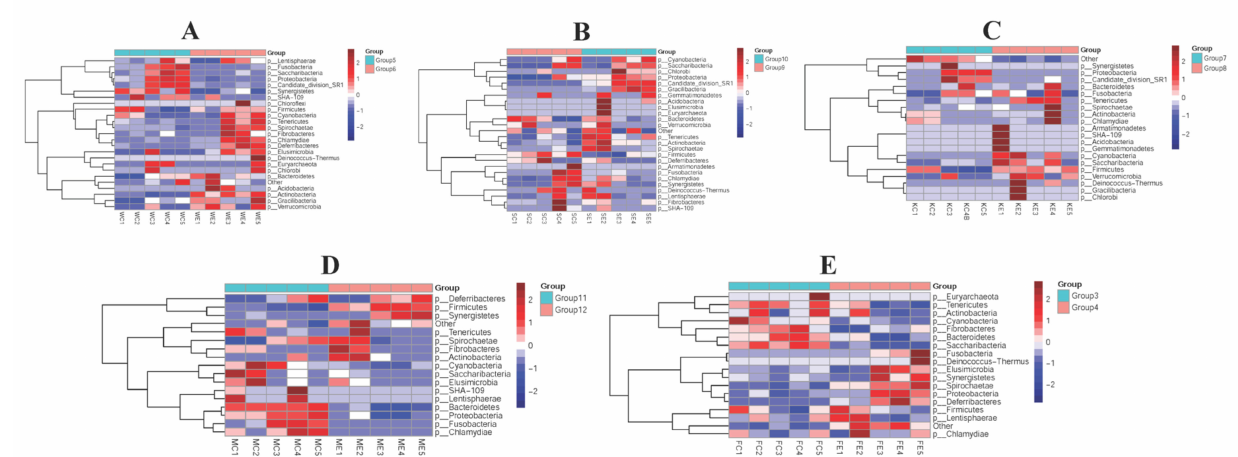
Figure 4. Heatmap showing the efficacy of colistin on piglet microbiome change at phylum levels. ( A ) Stomach (Group 6, Group 5); ( B ) duodenum (Group 10, Group 9); ( C ) jejunum (Group 8, Group 7); ( D ) cecum (Group 12, Group 11); ( E ) feces (Group 4, Group 3); colistin treated group: Group 6 (WE1, WE2, WE3, WE4, WE5), group 10 (SE1, SE2, SE3, SE4, SE5), group 8 (KE1, KE2, KE3, KE4, KE5), Group 12 (ME1, ME2, ME3, ME4, ME5), and Group 4 (FE1, FE2, FE3, FE4, FE5); control group: Group 5 (WC1, WC2, WC3, WC4, WC5), group 9 (SC1, SC2, SC3, SC4, SC5), Group 7 (KC1, KC2, KC3, KC4, KC5), Group 11 (MC1, MC2, MC3, MC4, MC5), and Group 3 (FC1, FC2, FC3, FC4, FC5).